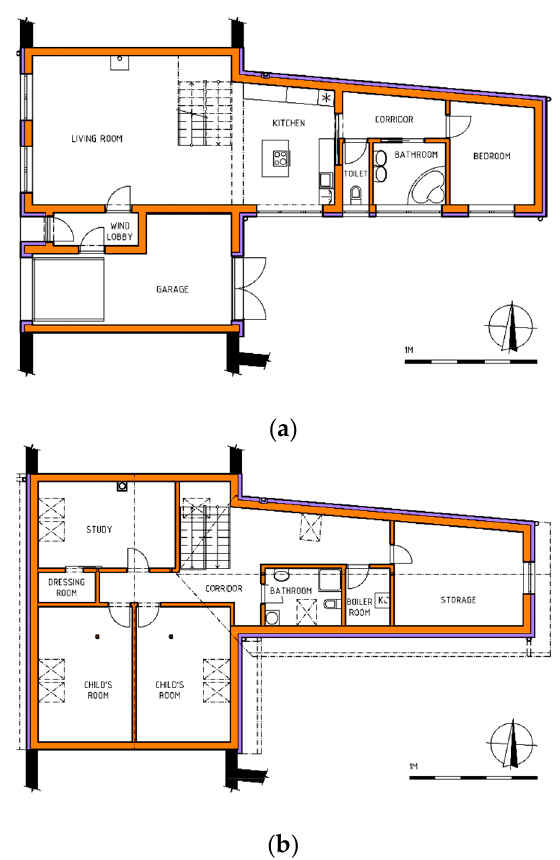
Figure 3. Newly constructed terraced house replacing the original as evaluated in V-3 LCA: ( a ) ground floor plan and ( b ) habitable attic plan with coloured hatching indicating different construction materials. Black = envelope walls of adjacent houses, grey = original structures, orange = hollow ceramic blocks, purple = additional EPS thermal insulation of the façade.